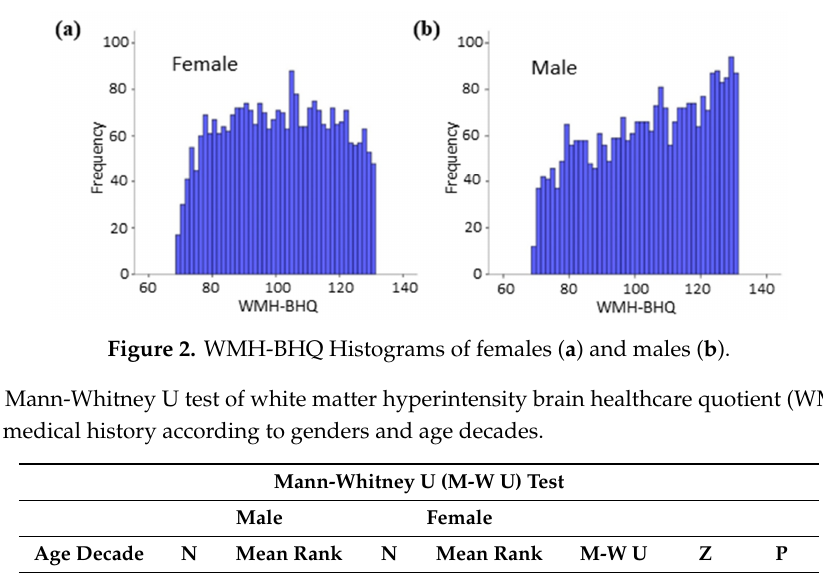
Table 3. Mann-Whitney U test of white matter hyperintensity brain healthcare quotient (WMH-BHQ) without medical history according to genders and age decades.